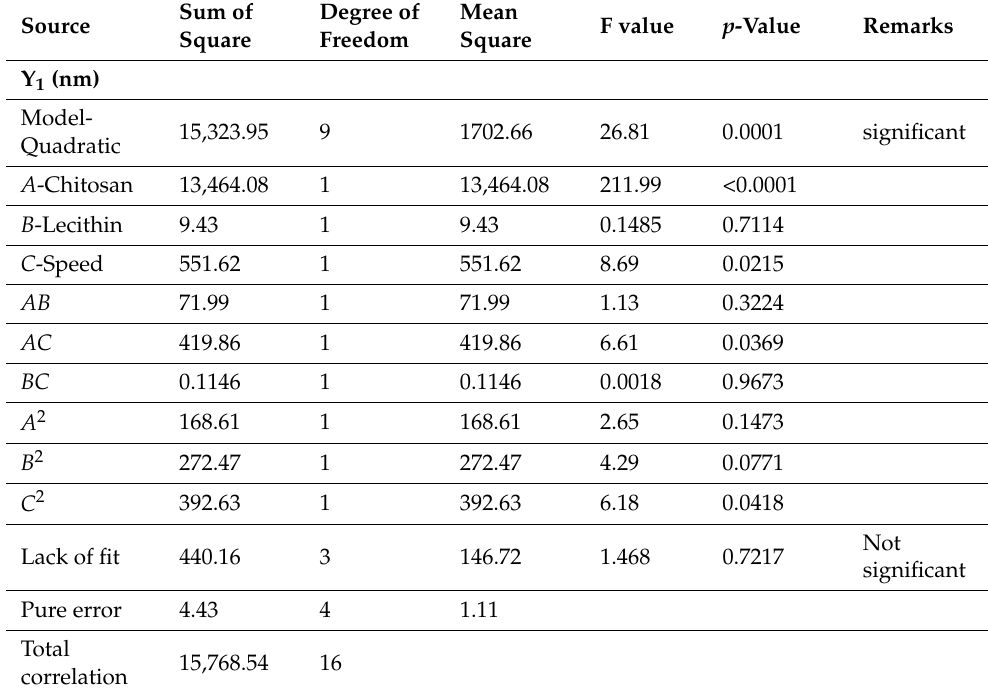
Table 4. ANOVA test for the dependent variables (particle size, zeta potential, and entrapment efficiency of